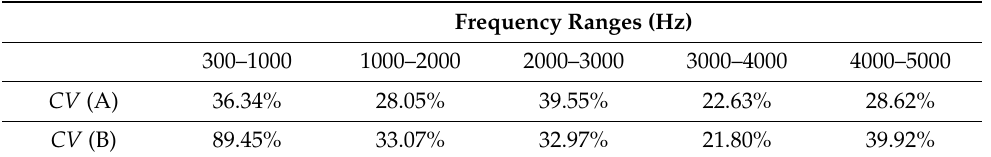
Table 1. CV value calculated between the numerical results and the experimental results of specific frequency